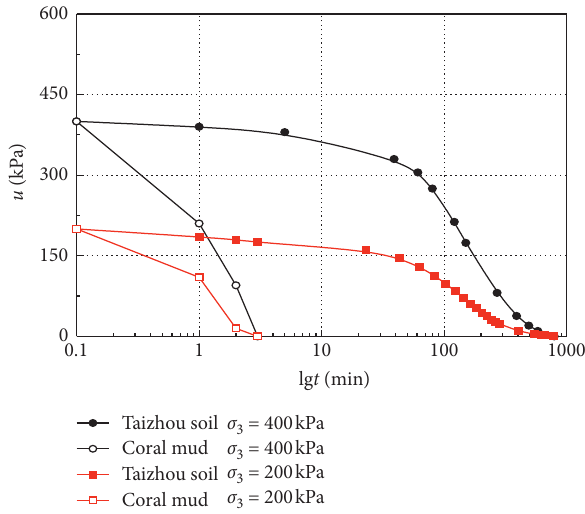
Figure 7: Pore pressure dissipation curve at the consolidation stage.